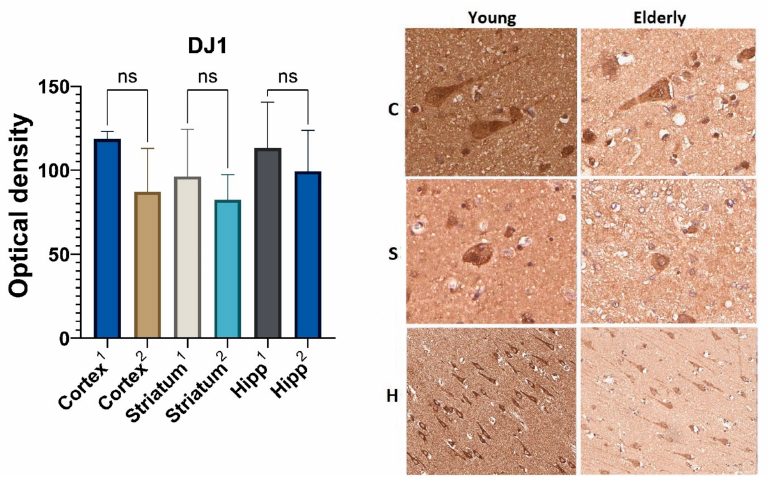
Figure 6. Results of DJ1 immunohistochemical staining: 1—young group, 2—elderly group; C—cortex, S—corpus striatum, H—hippocampus. ns—differences are not statistically significant ( p > 0.05). Magnification 400 × for “C” and “S”, Magnification 200 × for